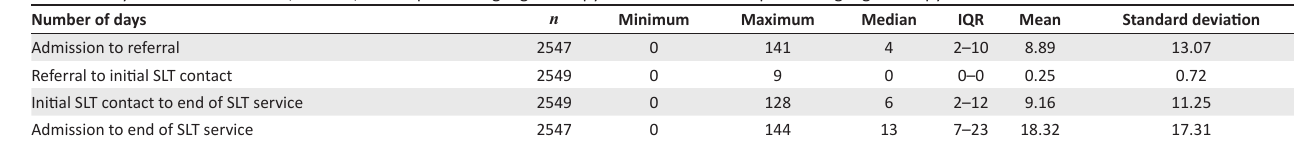
TABLE 6: Days between admission, referral, initial speech-language therapy contact and end of speech-language therapy service.